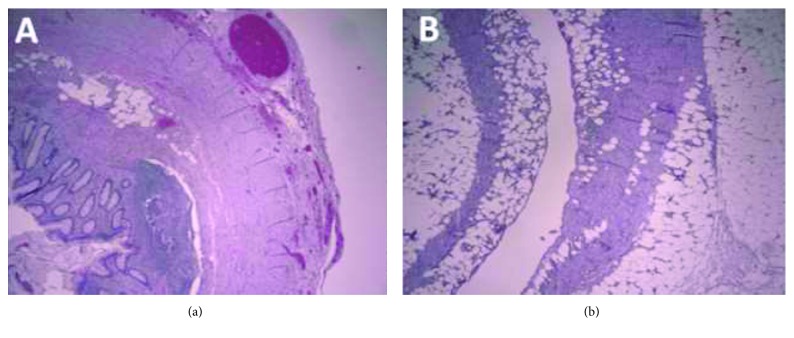
(a) Hemotoxylin and eosinophilin staining at 4x magnification of the resected appendix demonstrating serosal congestion, edema, and fibrosis. (b) Hemotoxylin and eosinophilin staining at 4x magnification of the resected hernia sac adipose tissue demonstrating septal fibrosis and inflammation